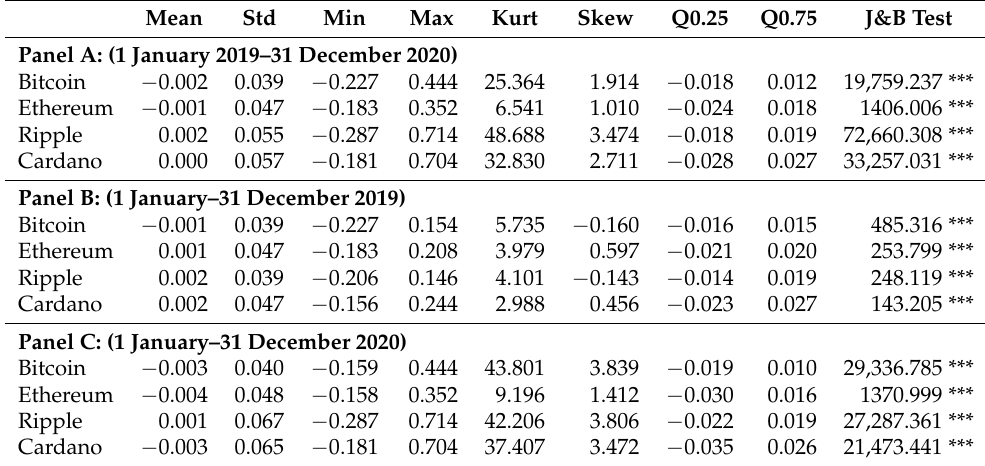
Table 4. Descriptive Statistics—Cryptocurrencies returns January 2019–December